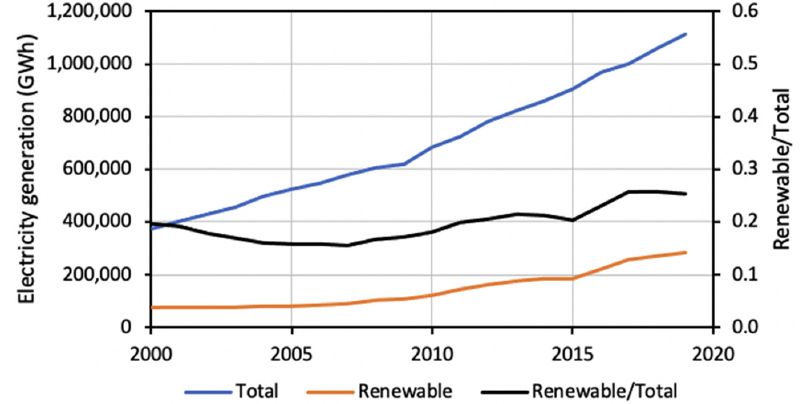
Figure 17. ASEAN electricity generation by type in 2019 [22] .